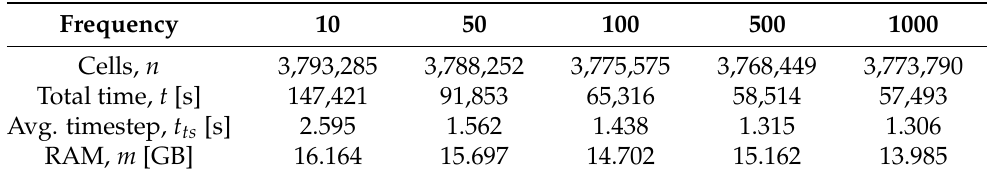
Table A11. Influence of the refinement frequency on the computational time. Setup is identical to Table A7 with load balancing enabled and performed when the imbalance reaches 5%.